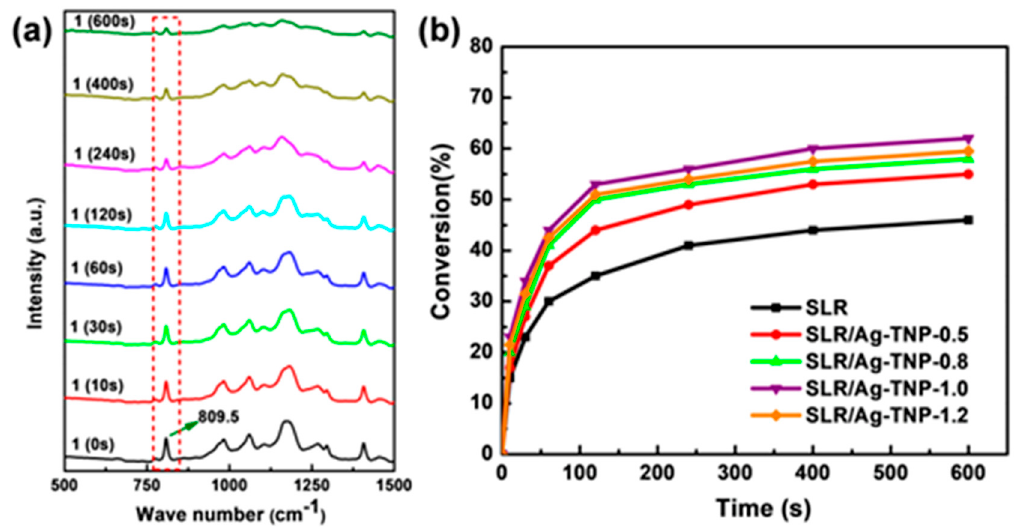
Figure 11. ( a ) a real-time FTIR analysis of photopolymerization of SLR/Ag-TNP-1 nanocomposite in different periods of time intervals starting from 0 s to 600 s under the UV irradiation power of 32 mW/cm 2 , ( b ) percentage conversion graph of neat SLR and SLR/Ag-TNP